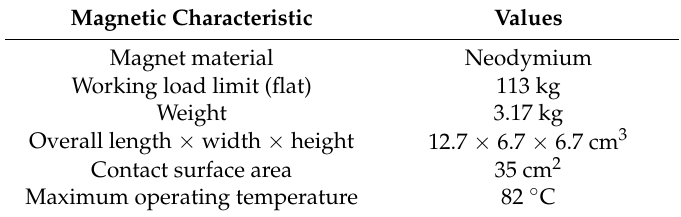
Table 1. Properties of lifting magnet, Mag-Mate PowerLift Magnet model PNL0250, used in this study.